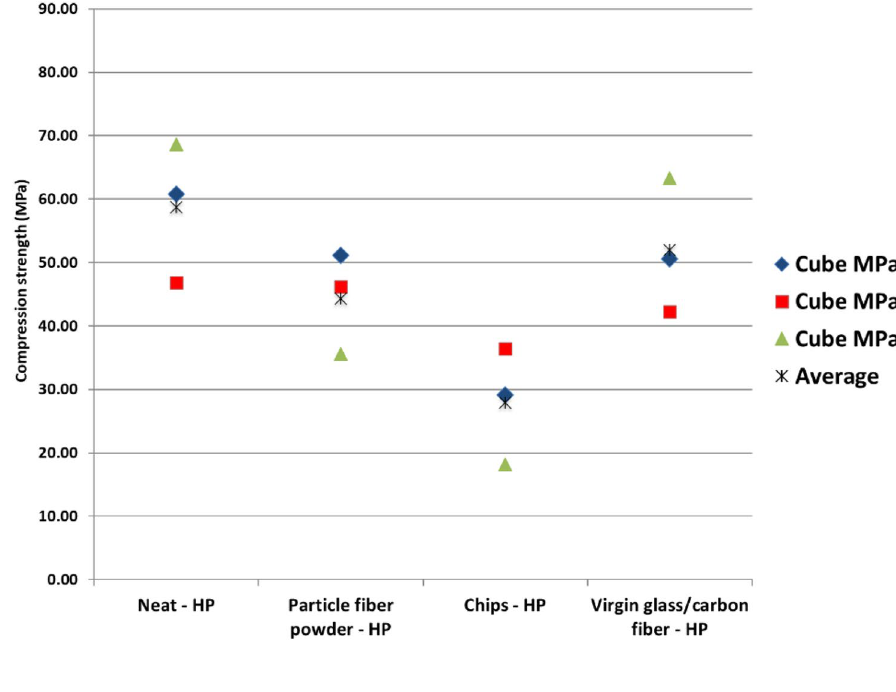
Fig. 8 a , b. a Post compression test analysis of the fractured prism specimens: low-pressure compacted cement with noticeably more internal voids compared to the high-pressure compacted cement b , which also contained fracture cracks as a result of compression